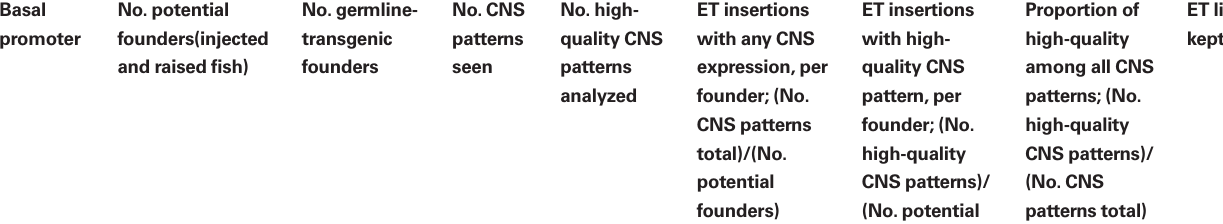
Table  | Summary of the output from the ET screen. Basal No. promoter